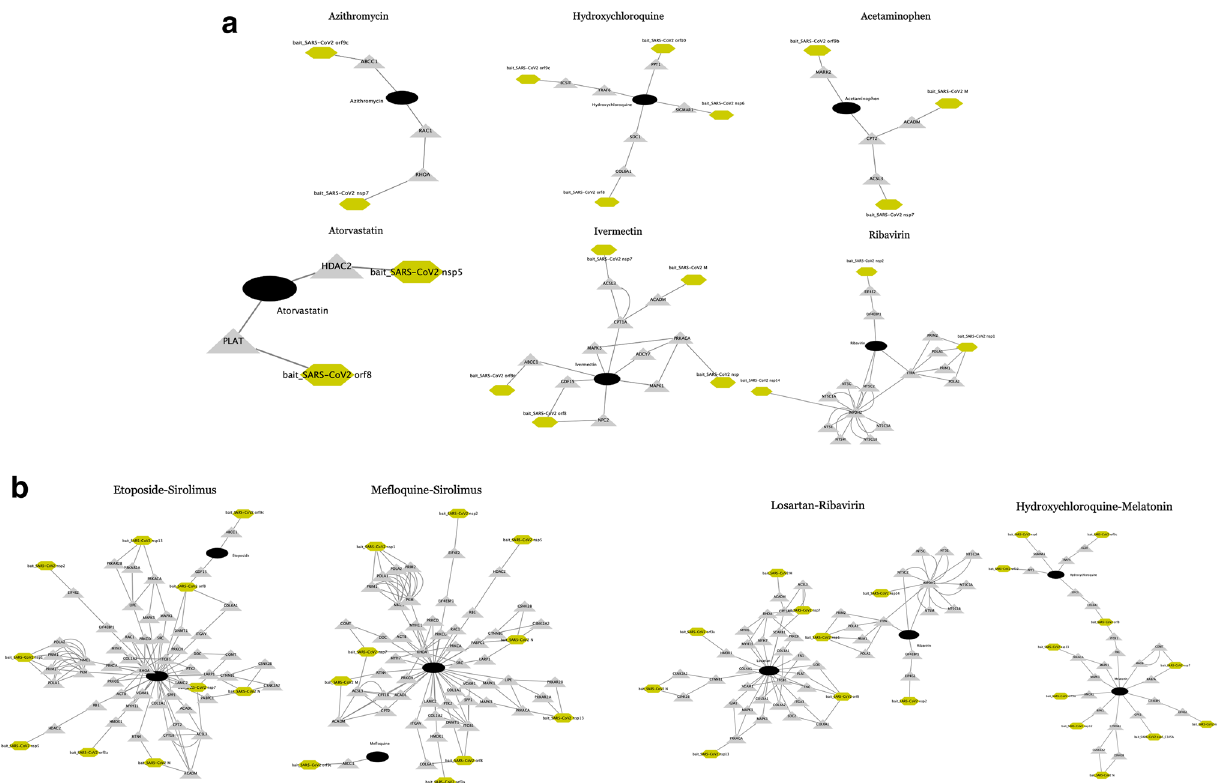
Figure 3. The interaction among virus baits, host preys, and drug targets. ( a ) Single drugs, ( b ) drug combinations. SARS-Cov-2 baits = green hexagons. Genes = gray triangles, Drugs = black rounds. The potentially repurposable drugs directly and indirectly target the host gene, which has PPI with the virus baits. Both figures are created by Cytoscape 44 . (https:// cytos cape.